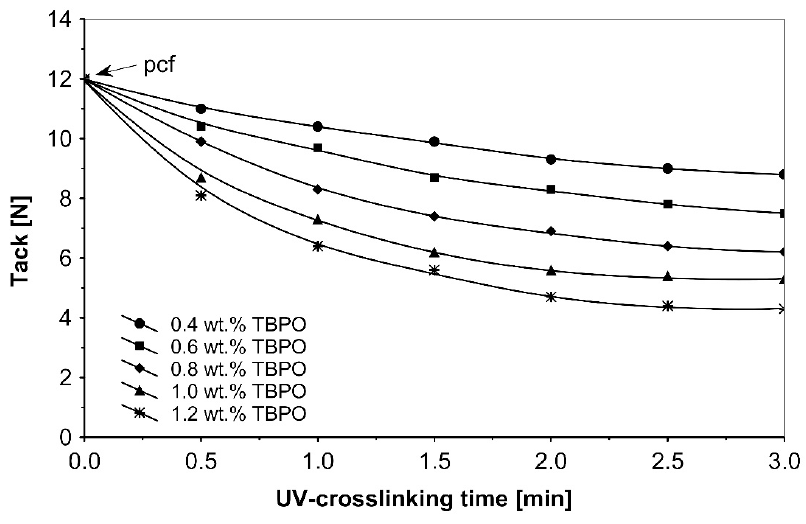
Figure 5. Tack versus UV ‐ crosslinking time for the use of tris ‐ benzophenyloxy phosphineoxide (TBPO). ide